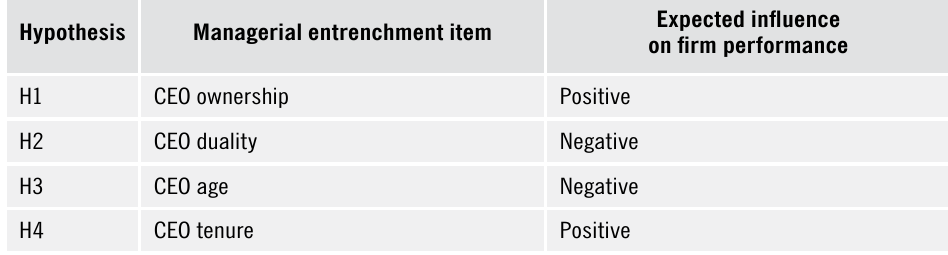
Table 1. Predicted relationship between firm performance and managerial entrenchment